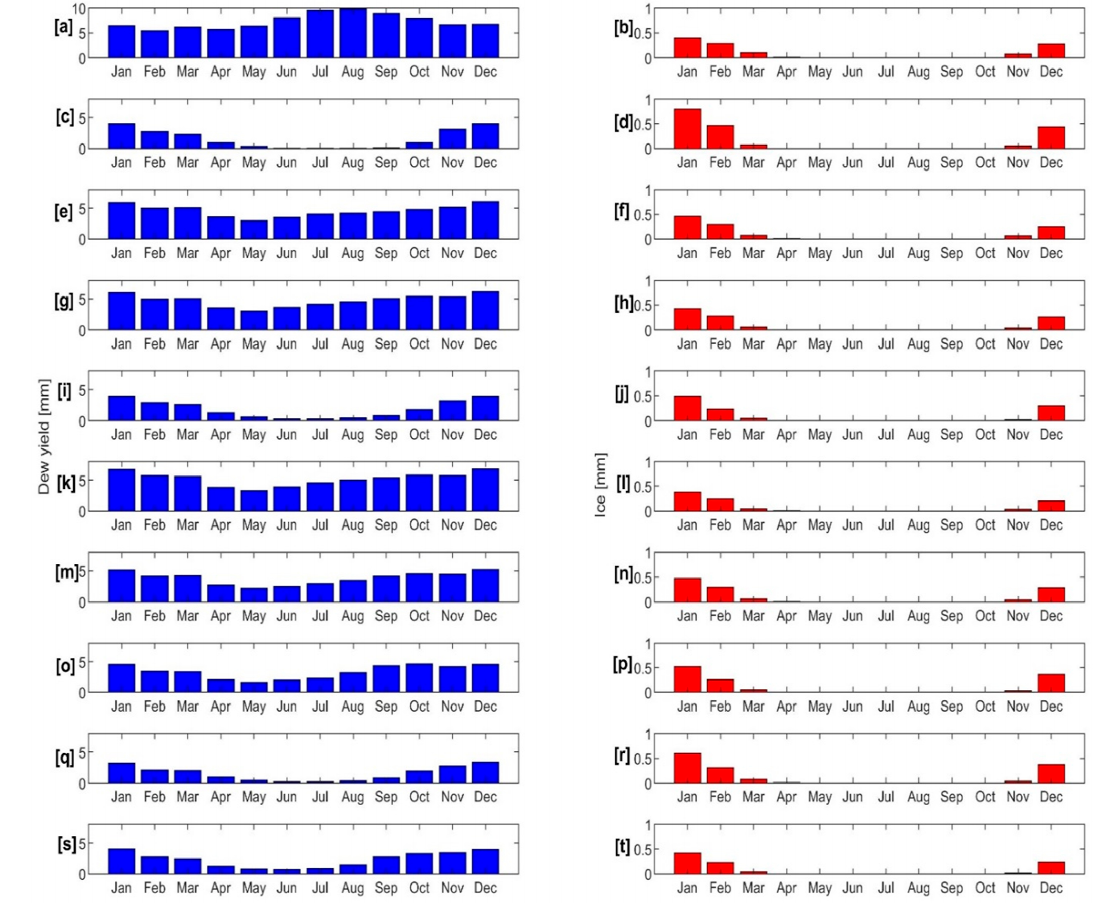
Figure 4. Mean monthly cumulative dew yield (left panel) and ice (i.e., hoarfrost) (right panel) at the selected sites during 1979–2018: ( a , b ) Irbid, ( c , d ) Mafraq, ( e , f ) Amman, ( g , h ) Madaba, ( i , j ) Azraq, ( k , l ) Dead Sea, ( m , n ) Karak, ( o , p ) Petra, ( q , r ) Ma’an, ( s , t ) Aqaba. The subplots are in sequential order according to site number from 1 to 10 (Figure 1).